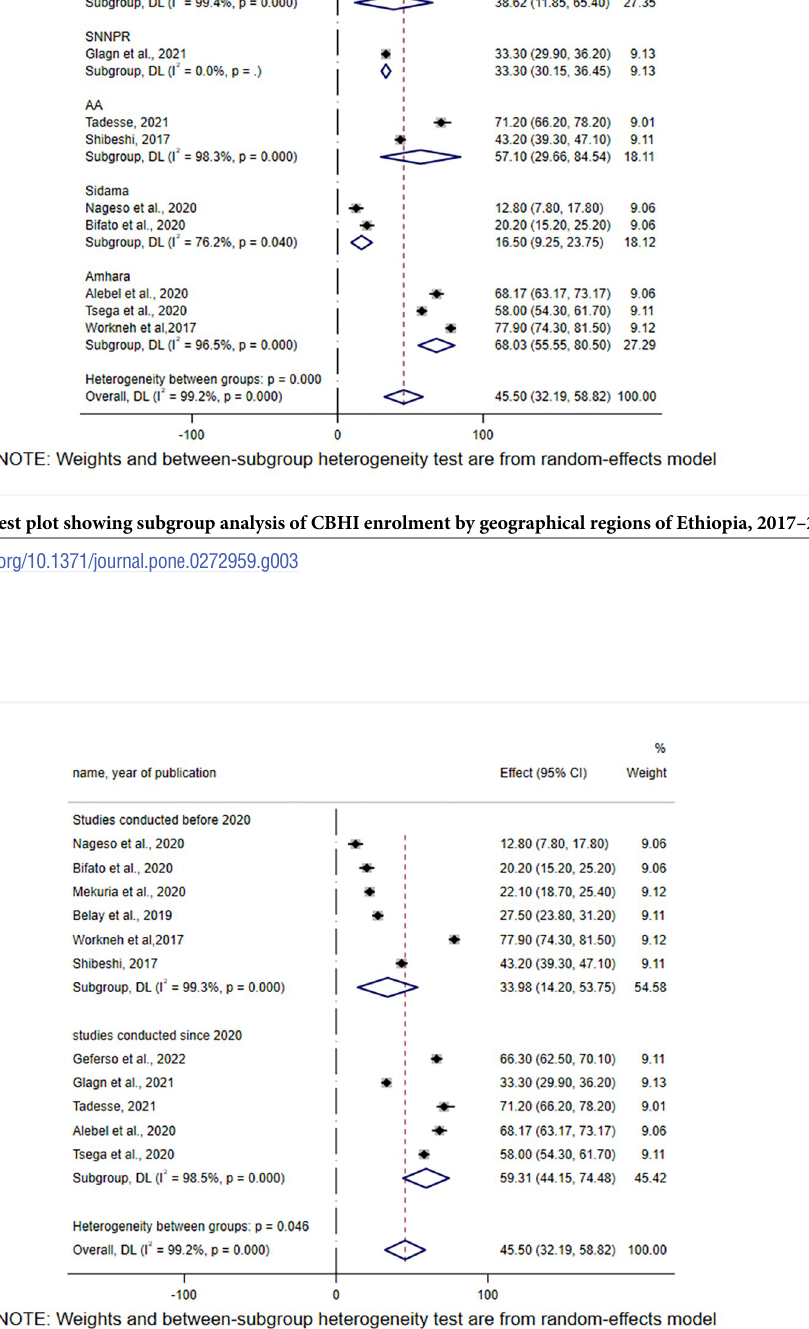
PLOS ONE | https://doi.org/10.1371/journal.pone.0272959 August 18,